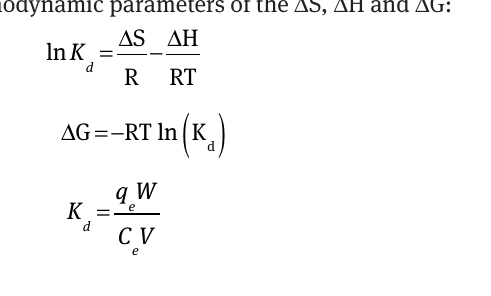
Table 6: Adsorption kinetics parameters at 30°C.